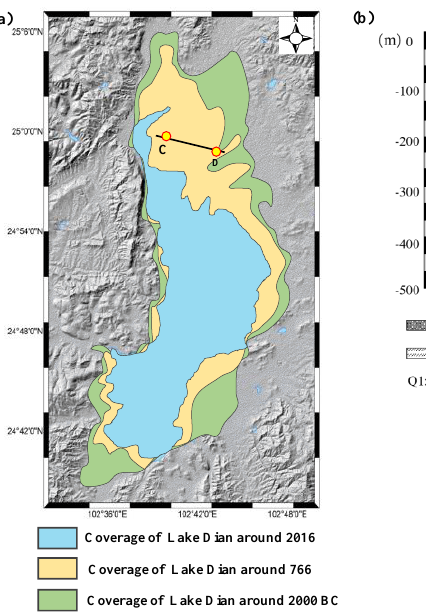
Figure 16. ( a ) Changes in the shoreline of Lake Dian; ( b ) stratigraphic profile along the line of CD, which corresponds to the position of boreholes.